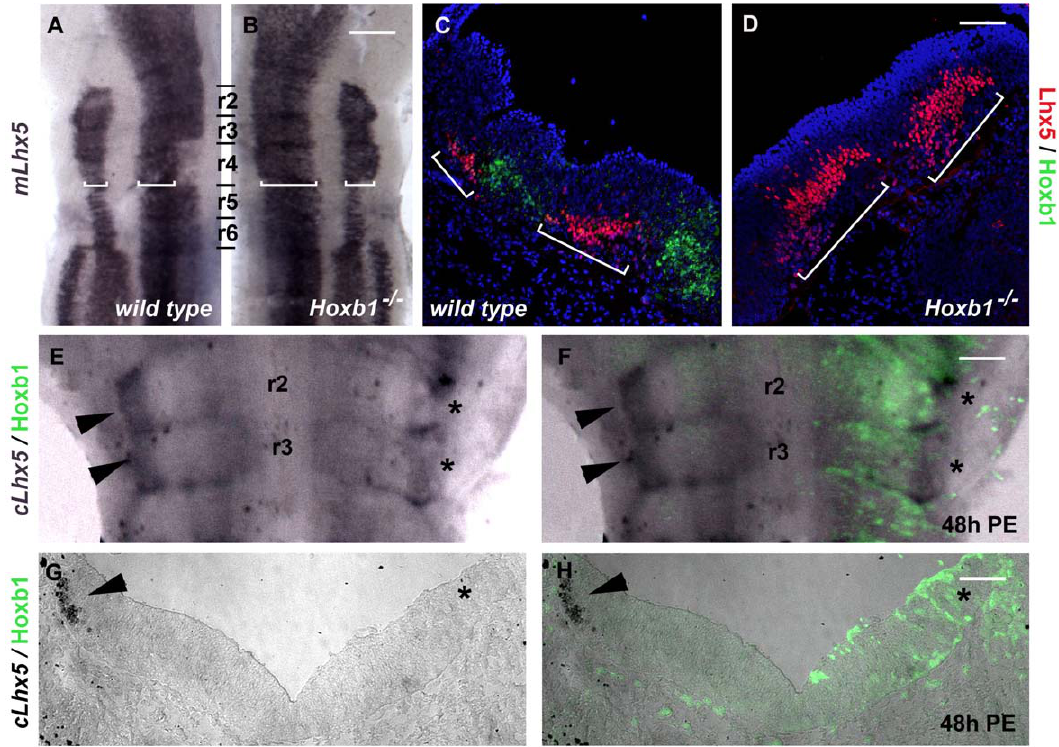
Figure 4. Expression of Lhx5 in mouse and chick hindbrain after Hoxb1 loss and gain of function experiments, respectively. (A–C) Expression of Lhx5 in ventricular views of flat mounted hindbrains (A, B) and r4 transverse sections (C, D) using Lhx5 in situ hybridization alone (A, B) or in combination with Hoxb1 immunofluorescence (C, D) of wt (A, C) and Hoxb1 2 / 2 (B, D) 10.5 dpc embryos. Lhx5 is expressed in two characteristic stripes in the mantle layer of r4 (A, C denoted by brackets) that expand substantially in the absence of Hoxb1 (brackets in B, D). (E–H) Expression of Lhx5 in flat hindbrains (E, F) and r2 transverse sections (G, H) of chick embryos electroporated at stage HH 10–11 and analyzed 48 h PE by in situ hybridization for chick Lhx5 and immunofluorescence for Hoxb1 (E–H). Expression of Lhx5 in the non-electroporated side is restricted at two dorsomedial r2 and r3 stripes (arrowheads E–H) and this expression is abolished upon Hoxb1 electroporation (asterisks E–H). Scale bar corresponds to 325 m m in A, B, to 100 m m in C, D, G, H and to 125 m m in E, F.